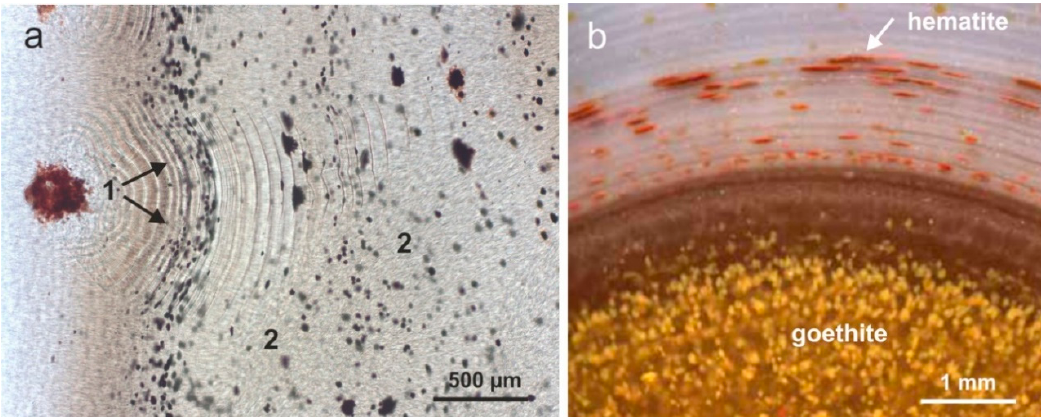
Figure 32. Incorporation of iron compounds as color pigments in agate: ( a ) micrograph in transmitted light of an agate from Hausdorf, Saxony (Germany) with iron oxides aligned along the banding (1) and random distribution in areas without banding (2); ( b ) agate from Pujiang, province Zhejiang (China) showing yellow color due to incorporation of goethite and red bands caused by hematite inclusions; note that hematite particles are flattened and aligned along the banding.